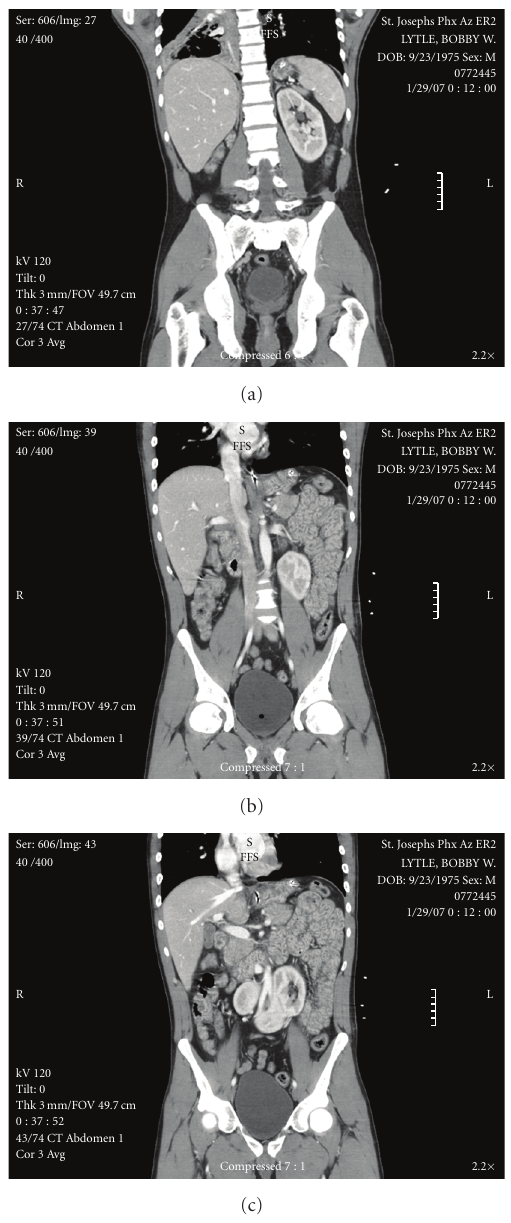
Figure 1: This is a series of coronal sections from a computed tomography (CT) scan of the abdomen and pelvis, done as a screening scan for abdominal trauma when the donor was admitted to the hospital. Image (a) shows the left kidney in a normal anatomic position. Image (b) shows the inferior fusion plane. Image (c) shows the right ectopic kidney, crossing the midline across the iliac